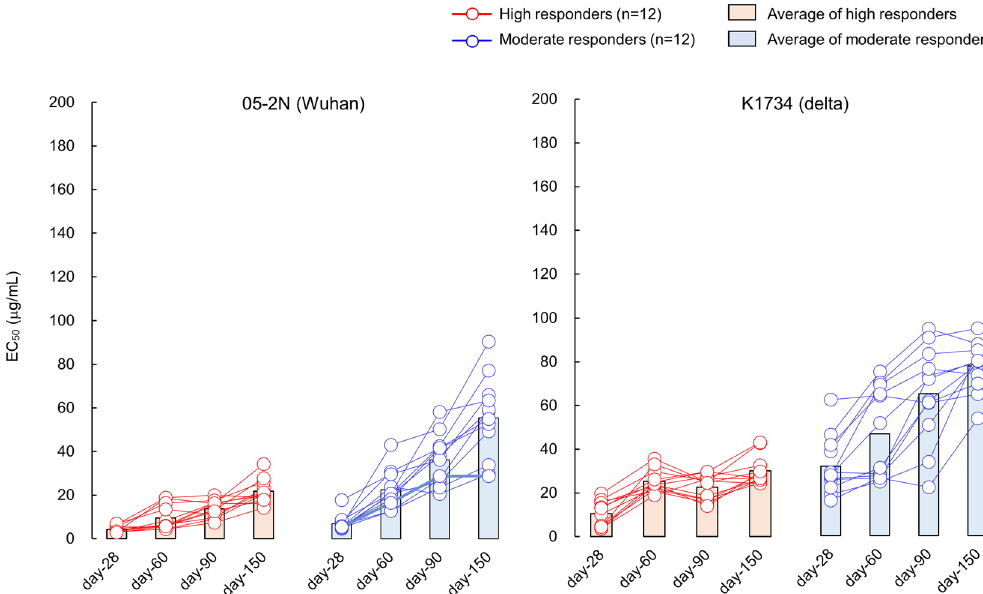
Figure 5. Anti-SARS-CoV-2 activity of IgG fractions eluted from day-28, -60, -90, and -150 sera of high and moderate responders against Delta variant. Time dependent alterations of antiviral activity of IgG fractions. Graph shows the EC 50 results of high and moderate responders against Delta variants, including IgG data obtained from sera of day-150 post 1st vaccine